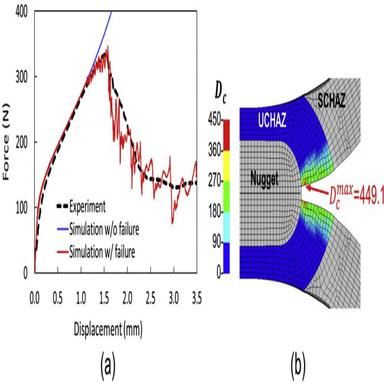
Determination of Dc for the mini-peel test. (a) Comparison between the calculated and experimental force-displacement curves; (b) the distribution map of Dc at the fracture point.